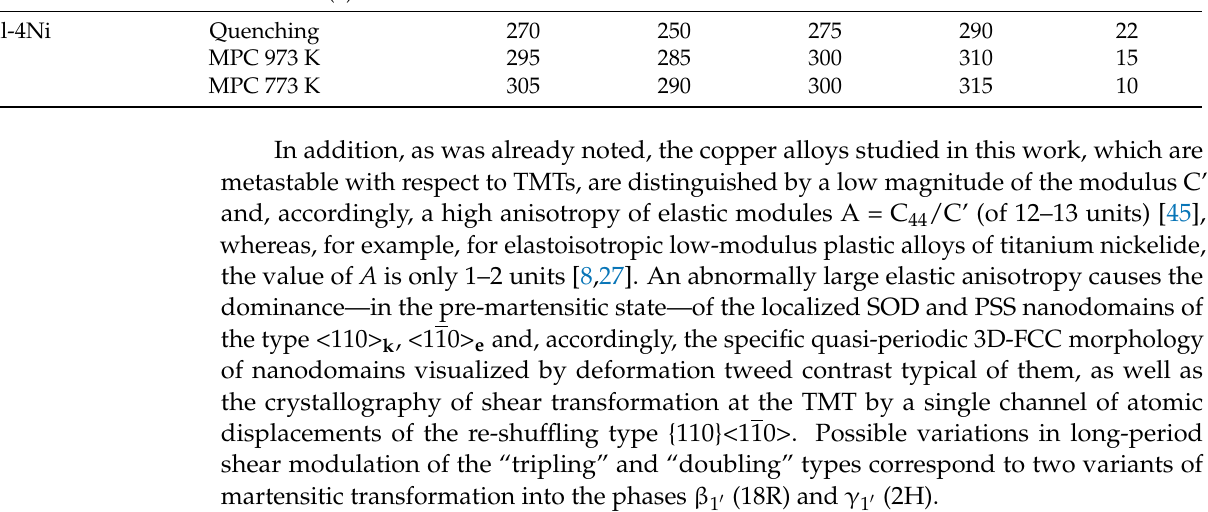
Figure 17. ( a ) Temperature dependences ρ (T) and χ (T) of the Cu–14Al–3Ni alloy after quenching from 1223 K into water upon thermal cycling: cooling from RT to 90 K—heat- ing to RT. ( b ) Temperature dependences of ρ (T) of the Cu-14Al-3Ni alloy after HPT in the measurement cycles 300 K → LN → 470 K → 300 K (curve 1) and 300 K → 573 K → 300 K (curve 2) (LN is an abbr. for liquid nitrogen). ( c – e ) Temperature dependences ρ (T) of the Cu-14Al-4Ni alloy after ( c ) quenching, ( d ) MPC at 973 K, and ( e ) MPC at 773 K. The thin arrows show the cycles of heating and cooling during the experiment [62].